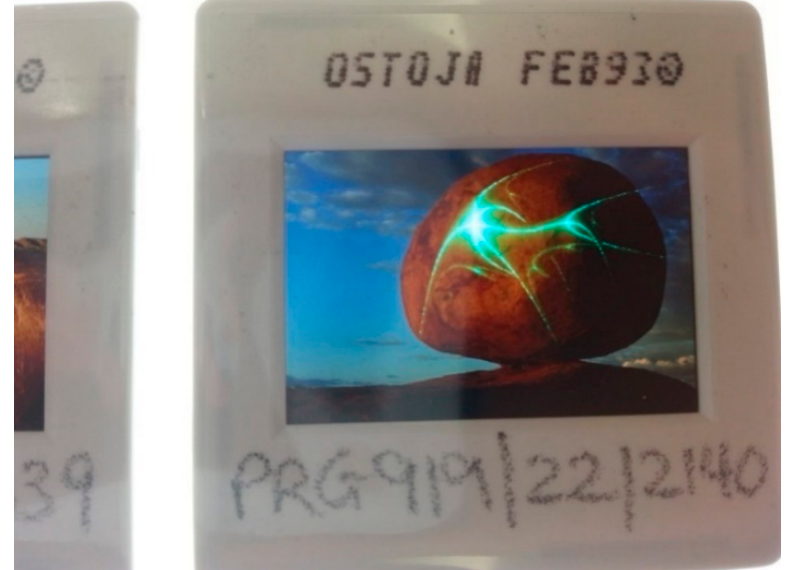
Figure 28. Composited landscape with CGI slide, dated February 1993. SLSA: PRG919/22/2140. Image courtesy Maria Garda. Published with permission of SLSA.